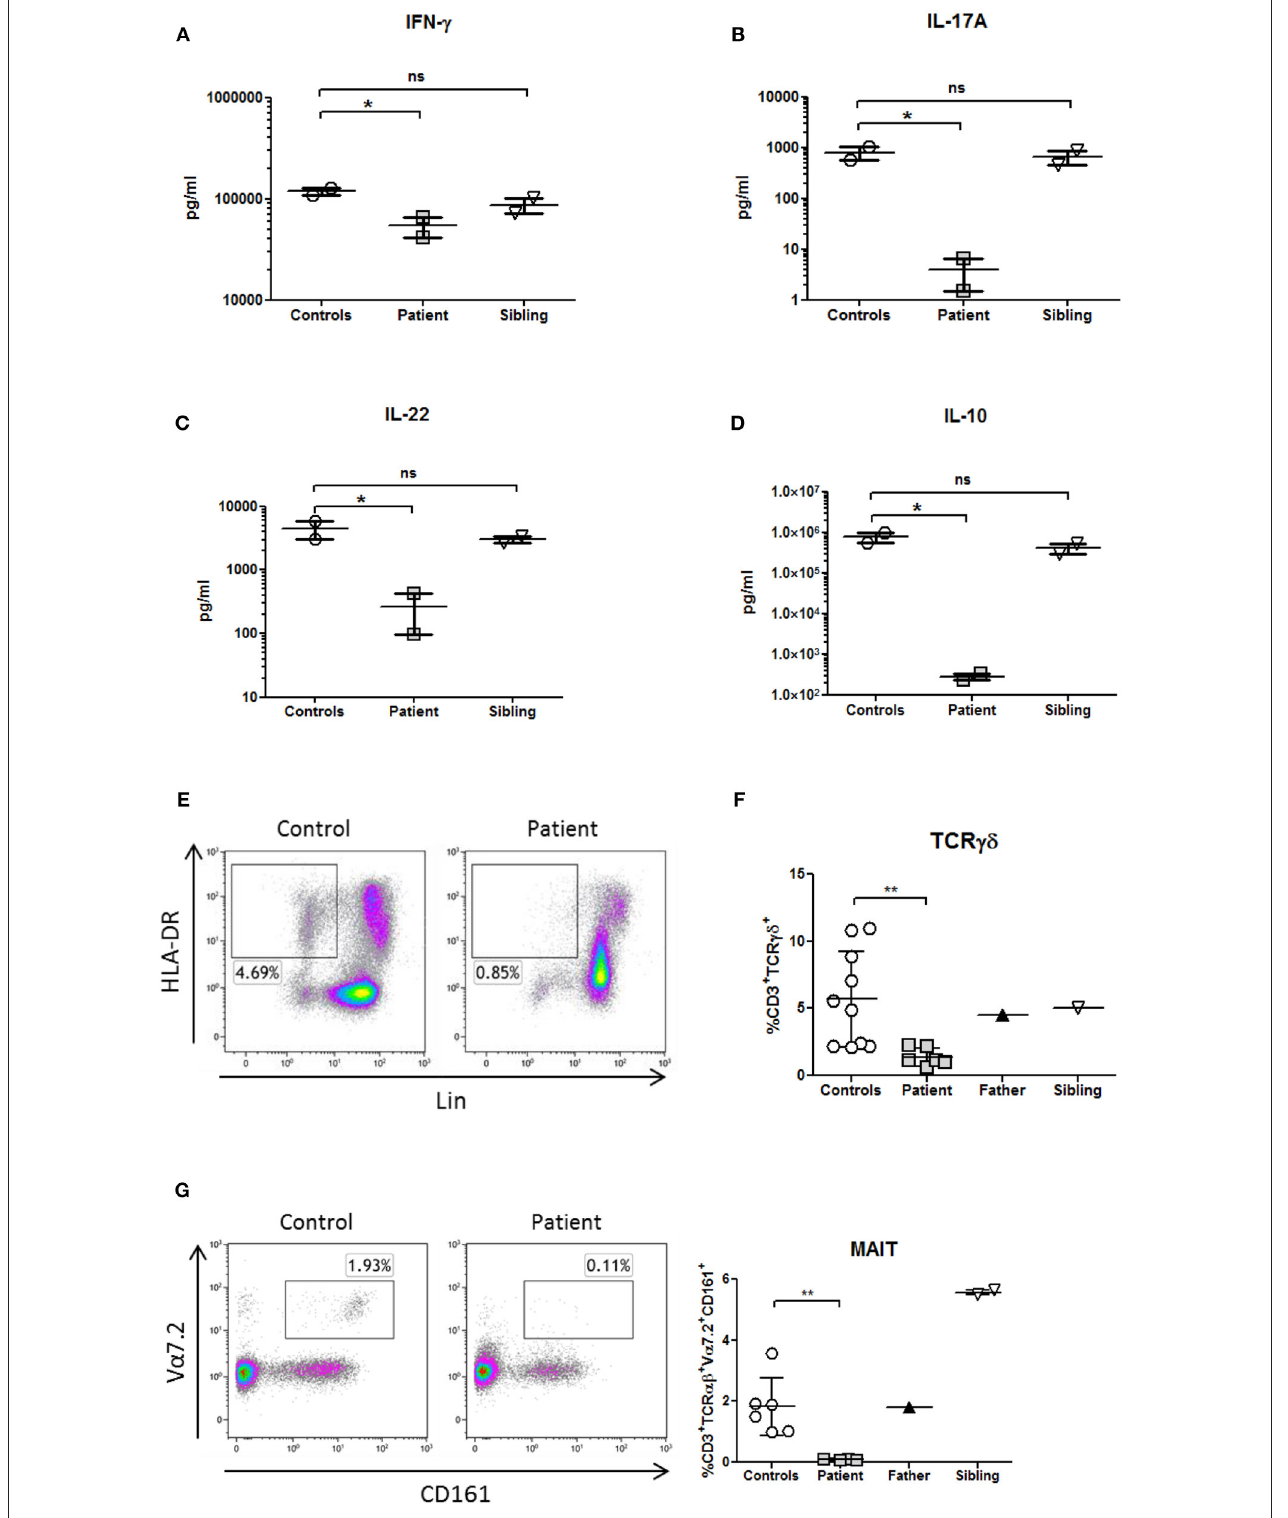
FIGURE 4 | Cytokines profile and innate immunophenotyping in a patient with NF- κ B1 deficiency. Cytokines were measured in supernatants from whole blood samples by Luminex and stimulated with PHA overnight (10 µ g/mL; Merck) (A) IFN γ production (Th1 cytokine) (B,C) , IL-17A, and IL-22 production (Th17